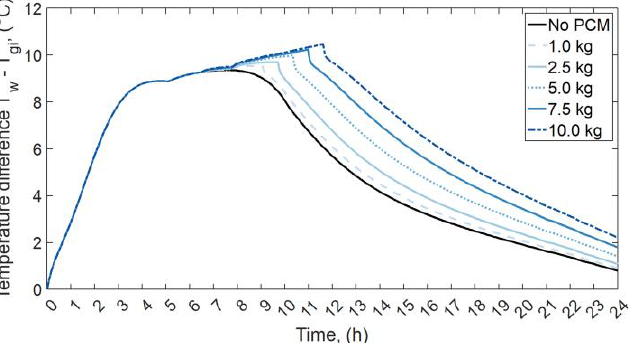
Figure 18. The temperature difference between water and inner glass cover in the SS with different masses of PCM — Case 3.